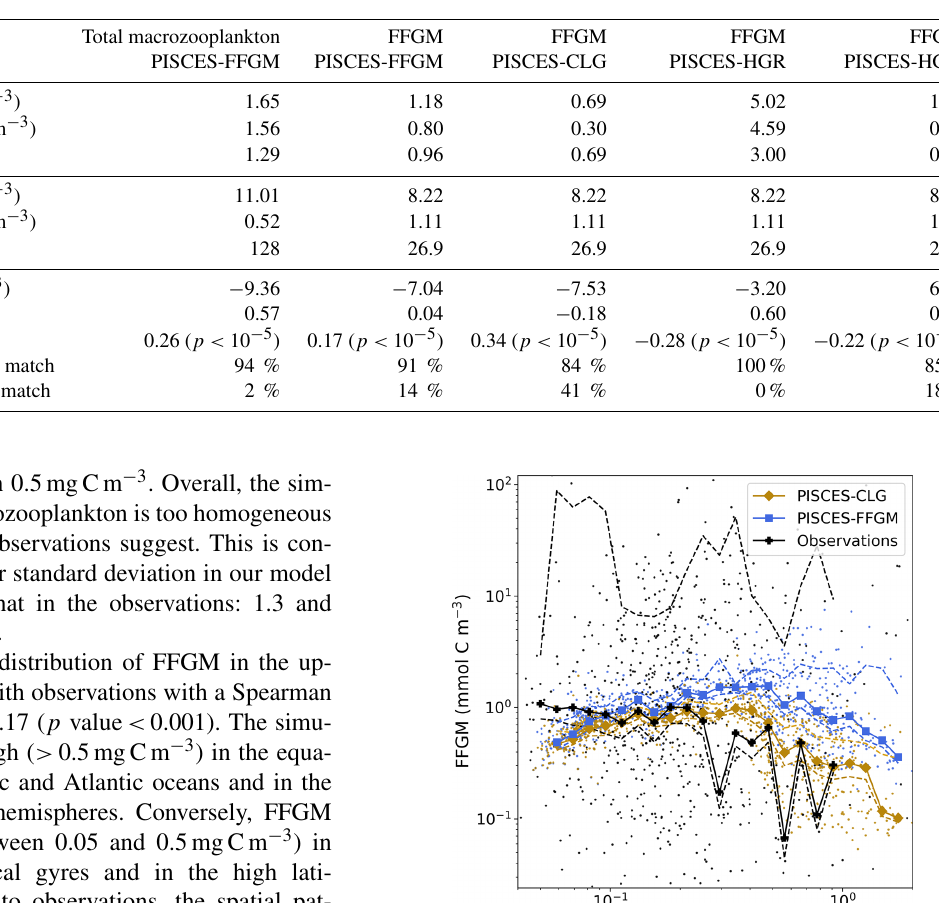
Table 4. Macrozooplankton model vs. observation statistics. “Mean”, “median” and “standard deviation” are computed on all the non-zero biomass values of the annual climatologies (as defined in Sect. 2.4.3) weighted by their respective cell areas. “Bias” is computed as the difference between modeled and observed means. “Bias (log10)” is computed on log10-converted observed and modeled climatologies. “R Spearman” is the Spearman correlation coefficient computed on non-zero values of the climatologies. “High biomasses match” is the percent- age of observed area where biomasses greater than 0.5mgCm − 3 correspond to area where model biomasses are greater than 0.5mgCm − 3 . “Low biomasses match” is the percentage of observed area where biomasses lower than 0.5mgCm − 3 correspond to area where model biomasses are lower than 0.5mgCm − 3 . The cut-off value of 0.5mgCm − 3 , used for defining high- and low-biomass regions, corresponds to the rounded median value of the macrozooplankton observations from MAREDAT (see Sect. 2.4.2).